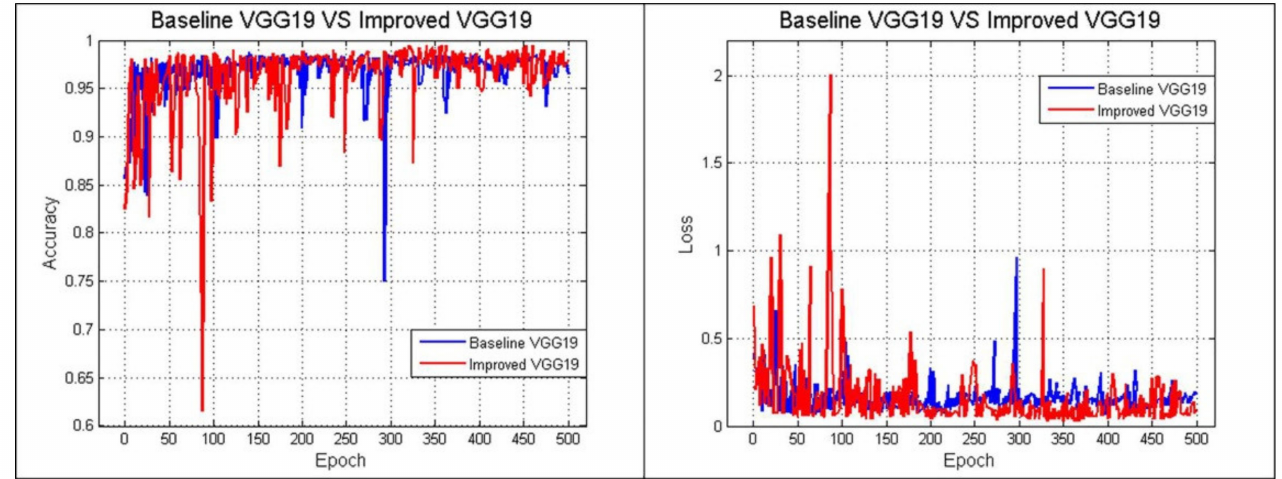
Figure 16. The accuracy and loss error differences between the baseline VGG19 and improved VGG19